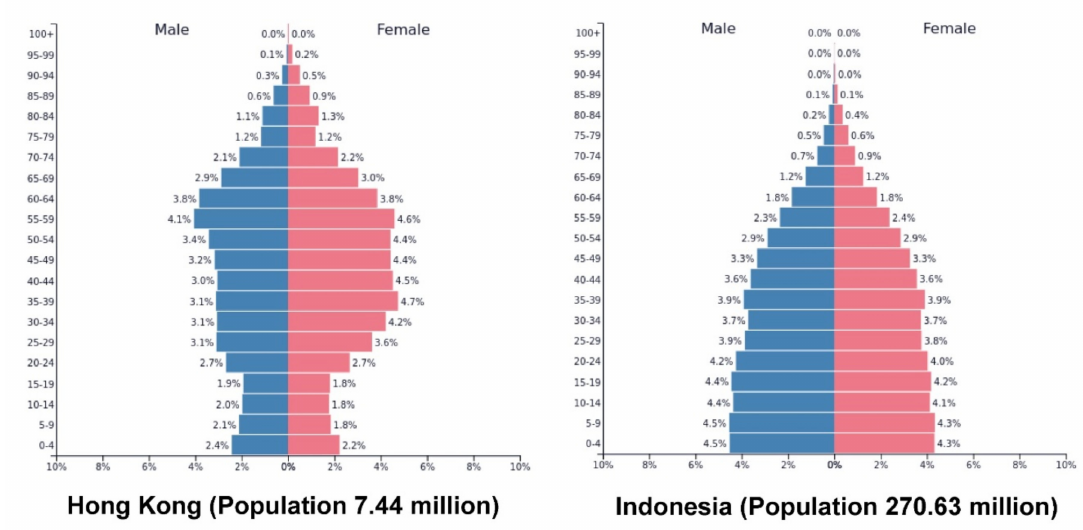
Figure 2. Population pyramids showing the distribution of sex and age groups in the population of Hong Kong and Indonesia in 2020 (PopulationPyramid.net,